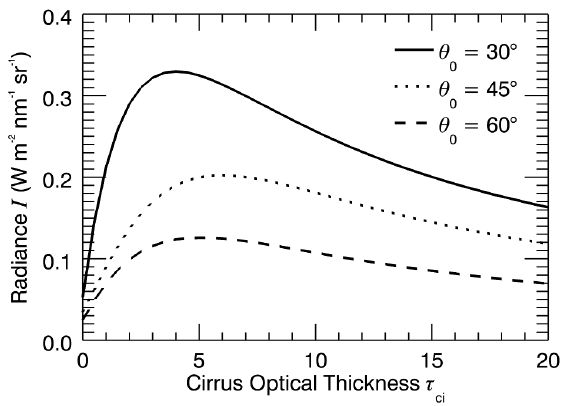
Fig. 6. Simulated radiance at 530nm as a function of cloud optical Fig.6: Simulatedradianceat530nmasafunctionofcloudopticalthickness.